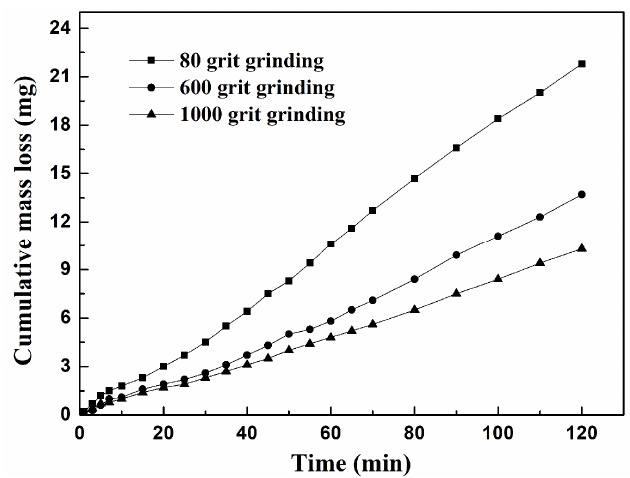
Figure 3. The relationship between cumulative mass loss and cavitation erosion time for the as-sprayed coatings with three surface roughness levels.